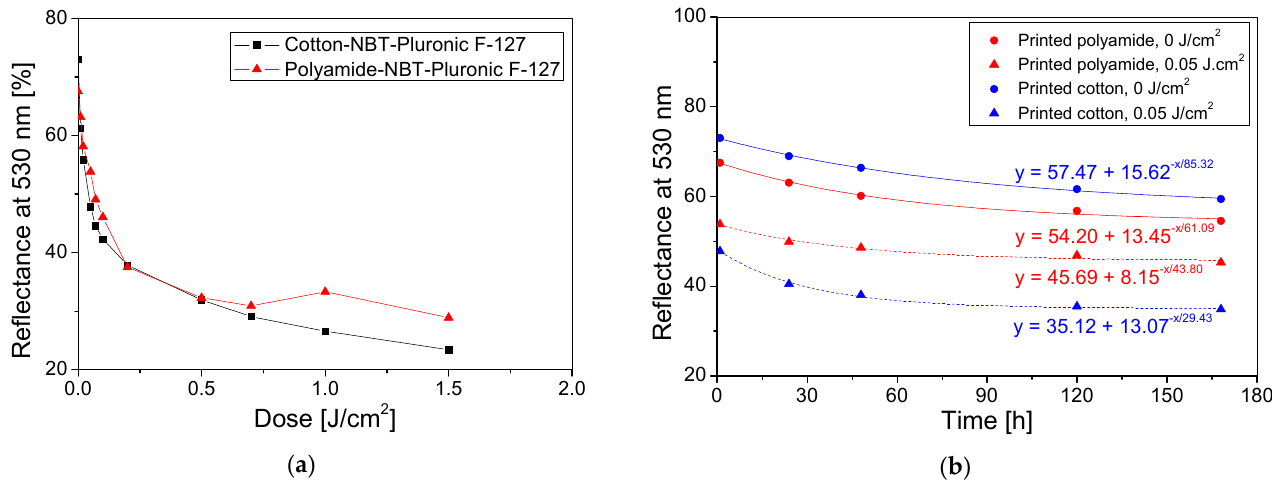
Figure 5. Dependence of the reflectance of light at 530 nm versus absorbed dose ( a ) and stability over time ( b ) for the cotton and polyamide fabrics printed with NBT-Pluronic F-127 hydrogel and irradiated with UVB radiation. The values of light reflectance for non-printed cotton and polyamide woven fabrics was: 79.60 and 72.60,